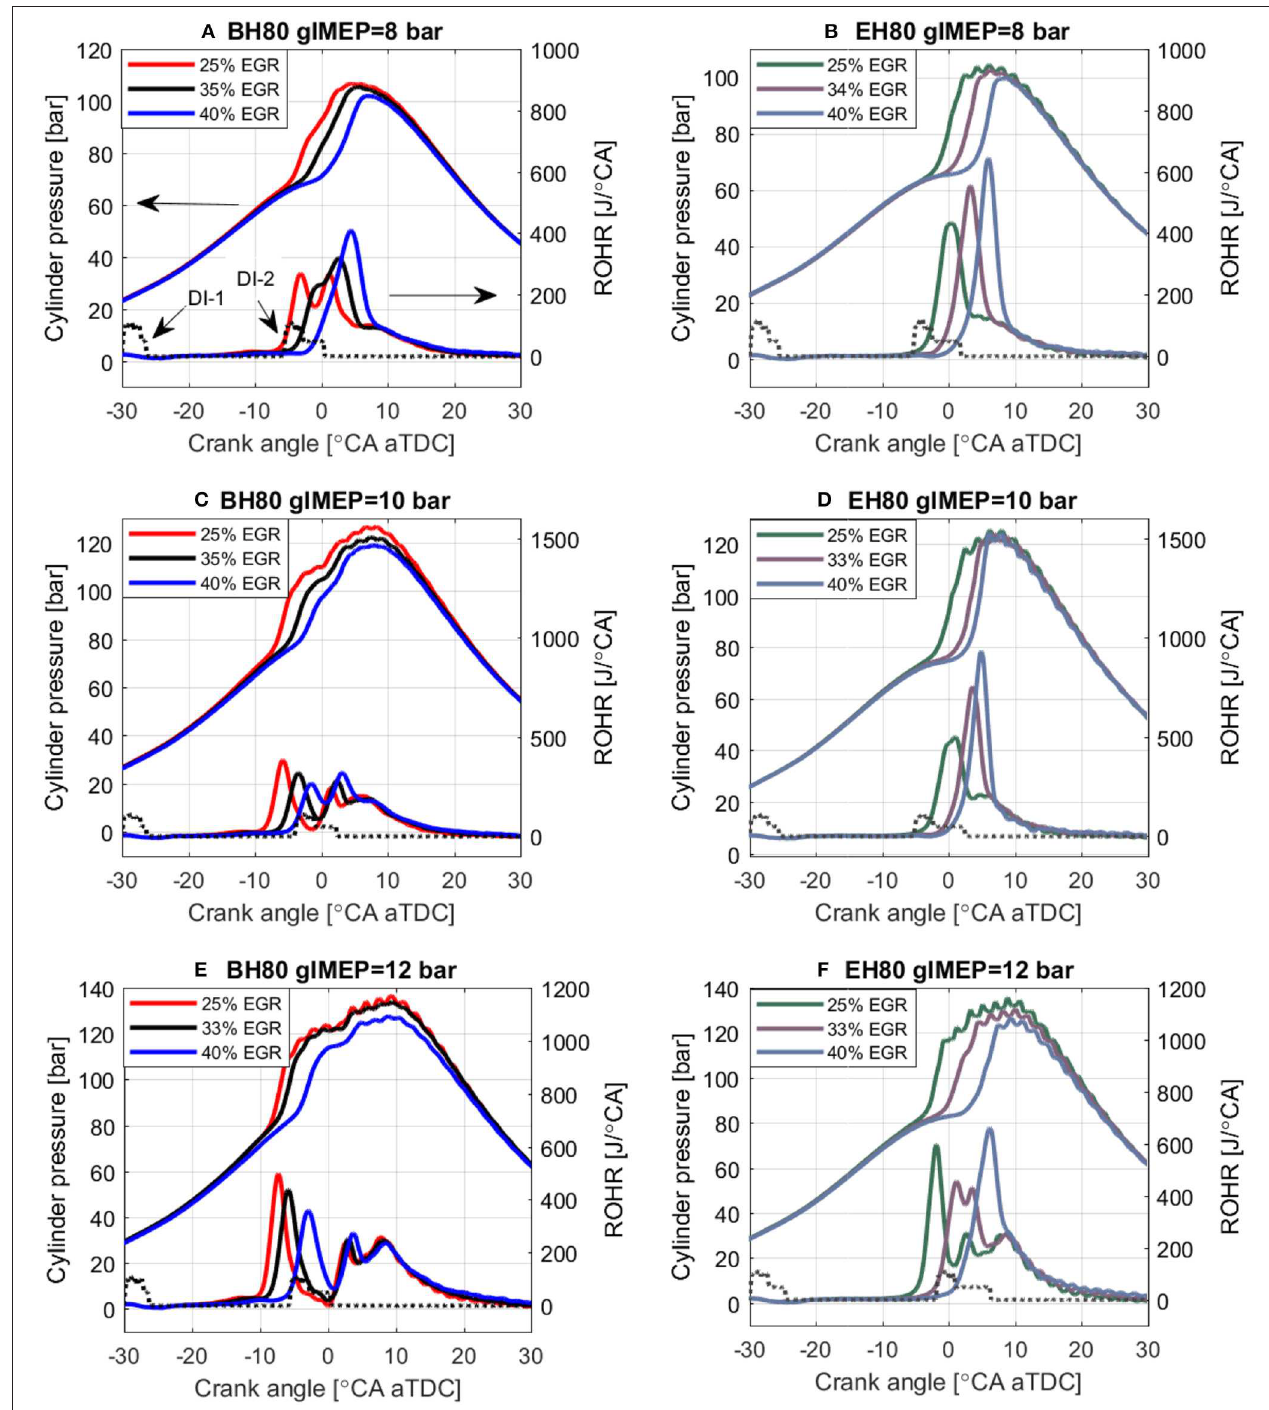
FIGURE 5 | Cylinder pressure and ROHR profiles of EH80 and BH80 at various loads and EGR rates. (A) BH80 gIMEP = 8 bar. (B) EH80 gIMEP = 8 bar. (C) BH80 gIMEP = 10 bar. (D) EH80 gIMEP = 10 bar. (E) BH80 gIMEP = 12 bar. (F) EH80 gIMEP = 12 bar.